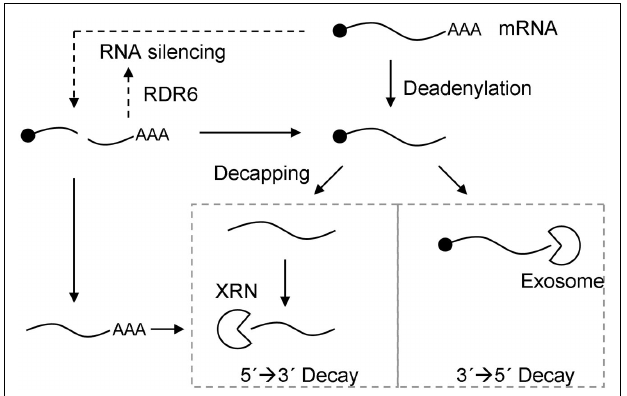
FIGURE 1 | Model for the relationship between RNA silencing and RNA decay pathways. Exonucleolytic mRNA decay can be initiated by deadenylation, followed by 3 (cid:2) → 5 (cid:2) degradation by the exosome, or decapping, followed by 5 (cid:2) → 3 (cid:2) degradation by the XRN family of exoribonucleases (closed arrows). Alternatively, RNA silencing can be induced by miRNA- or siRNA-guided cleavage of mRNA (dotted arrows). This generates uncapped and unpolyadenylated RNA products, which can either be substrates for RDR6 and secondary siRNA biogenesis to reinforce RNA silencing (dotted arrow), or substrates for the exonucleolytic RNA decay pathways (closed